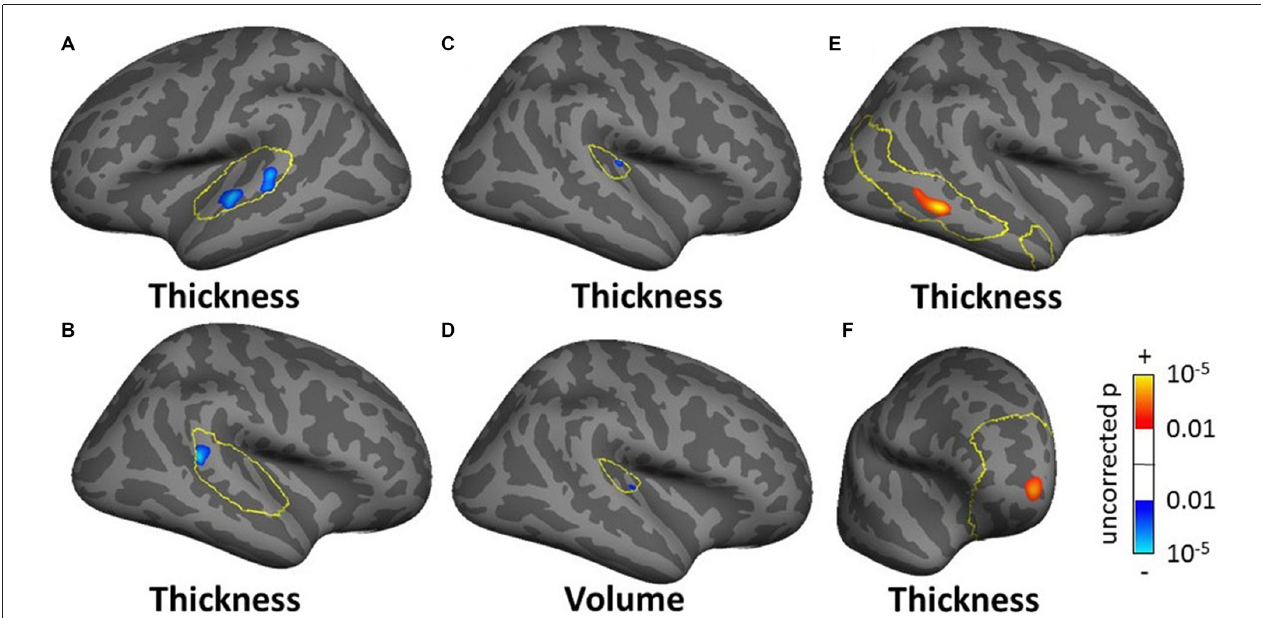
FIGURE 8 | Clusters showing a significant effect ( p < 0.05 FWE-corrected) of tinnitus in left AC (A) right superior temporal sulcus (STS; B) right Heschl’s gyrus (HG) (C,D) and of tinnitus severity in right middle temporal gyrus (MTG) and PFC (E,F) in the masked SBM analysis. The yellow outlines depict the masks used to restrict the vertexwise analysis (auditory cortex, AC for A,B HG for C,D default mode network (DMN) for E ; PFC for F) . Blue areas correspond to a negative effect (decrease in thickness or volume for the tinnitus group vs. the control group) and the red areas to a positive effect (increasing thickness for increasing tinnitus severity).